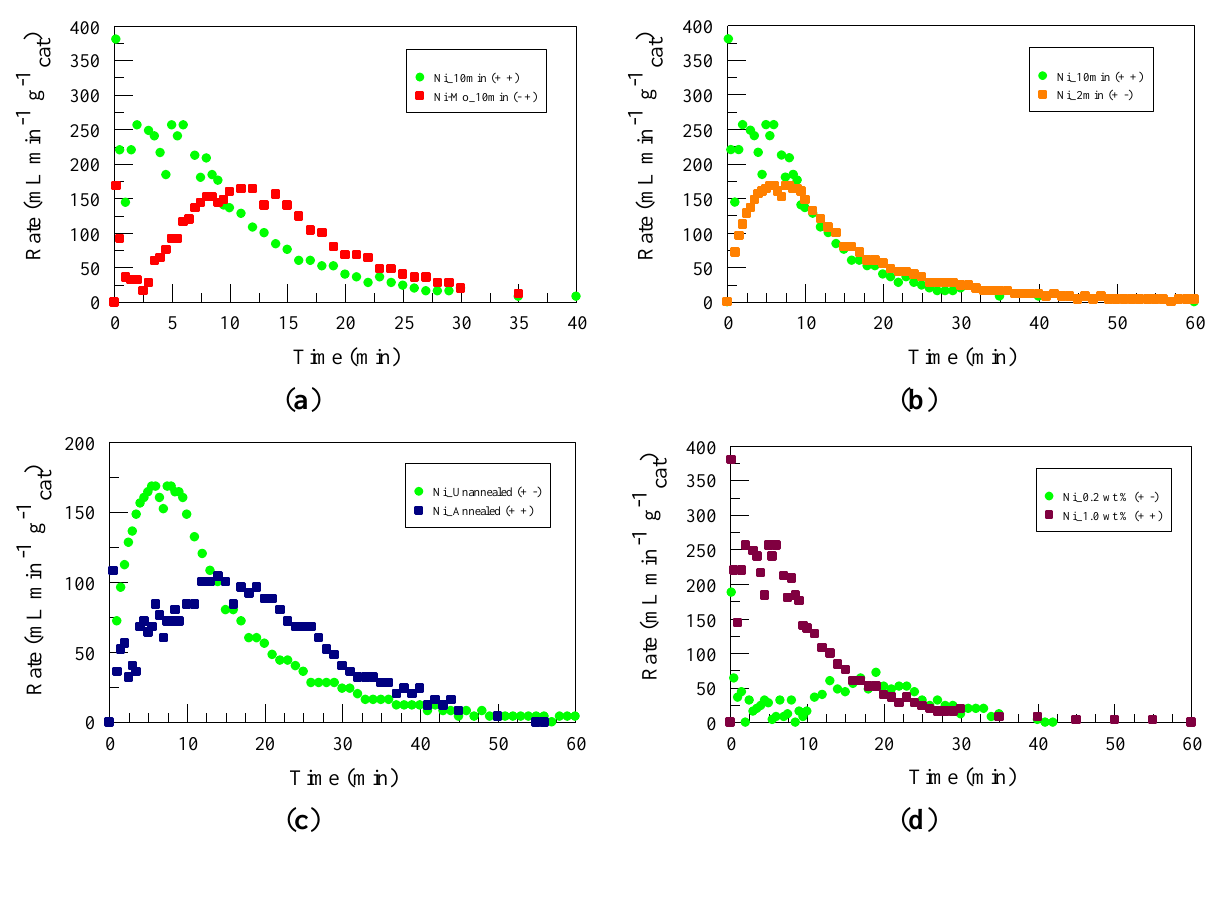
Figure 3. Hydrogen evolution rate at 50 °C and ( a ) 1.0 wt % NaBH ( c ) 2 min plating time; ( d ) 10 min plating